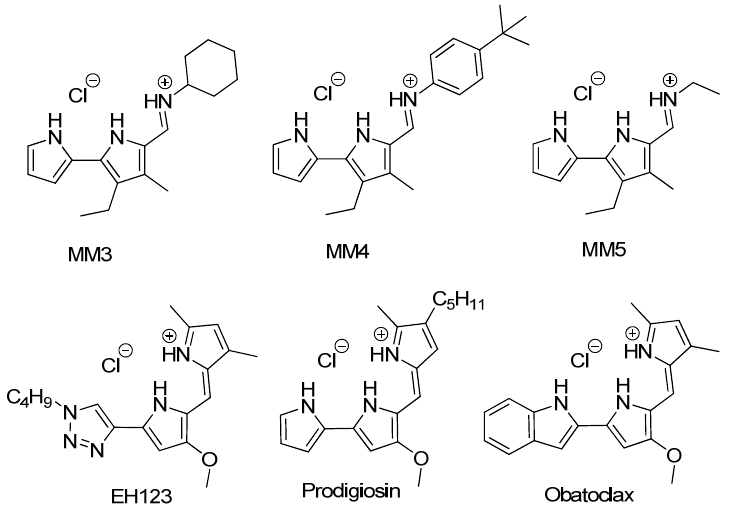
Figure 1. Chemical structure of the studied compounds.